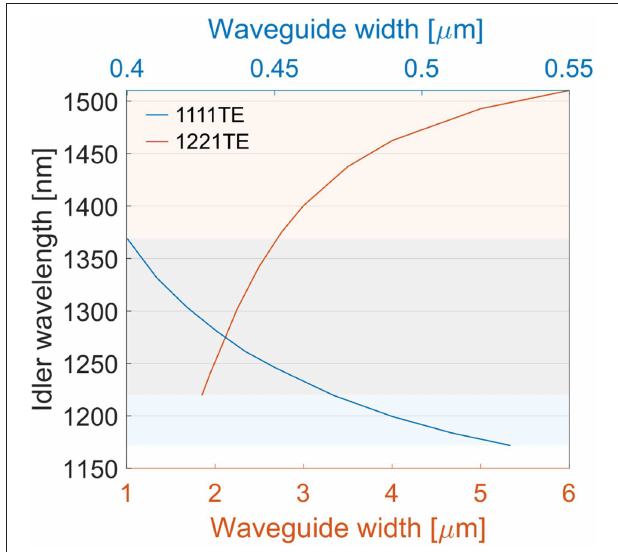
FIGURE 2 | Phase matched idler wavelength as a function of the waveguide width. The blue line refers to the intra-modal 1111TE FWM in a single mode channel waveguide with 243nm height. The orange line refers to the inter-modal 1221TE FWM in a rib waveguide with h = 300nm, h s = 190nm, h clad = 900nm and h sub = 2 µ m